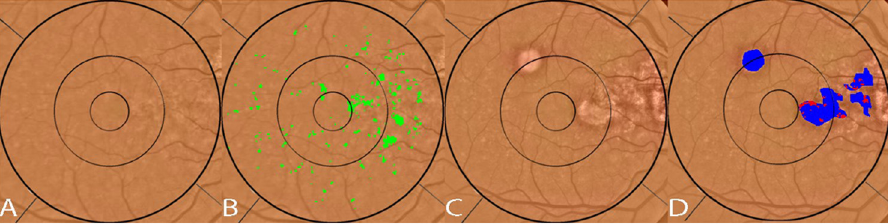
Fig 5. Drusen regression and its correlation with new geographic atrophy (GA). A: Color photo, right eye, Visit 1 (V1). B: V1 photo with soft drusen segmented in green, total pixel area 2,452. GA is not present. C: Color photo, right eye, Visit 5 (V5), showing new GA, D: V5 photo with GAs segmented in blue, total pixel area 4,161. Drusen from V1 that were absorbed in the GA are overlaid and segmented in red, total pixel area 381, or 9% of geographic atrophy total area. Compared to the original drusen area present in V1 of 2,452 pixels, the 381 drusen pixels converting to GA in V5 represent 16% of the original drusen